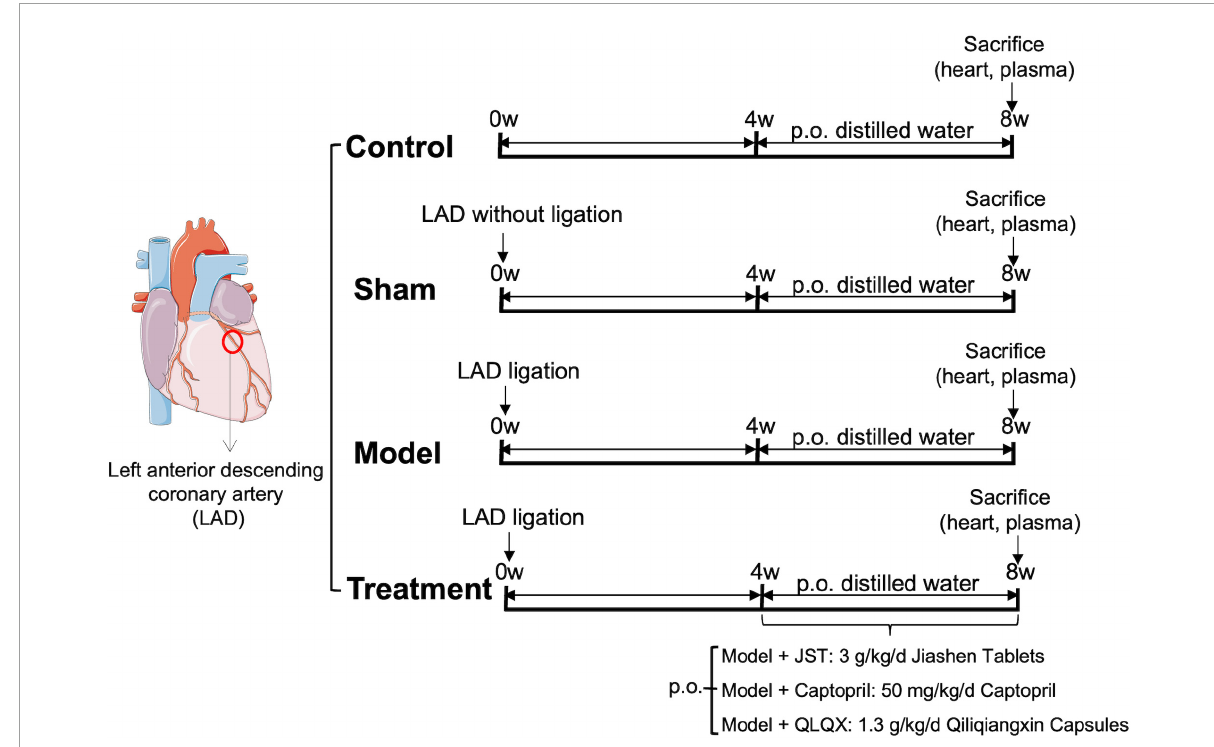
FIGURE1 Left anterior descending coronary artery (LAD) ligation for the establishment of rat heart failure model and dosage regimens.